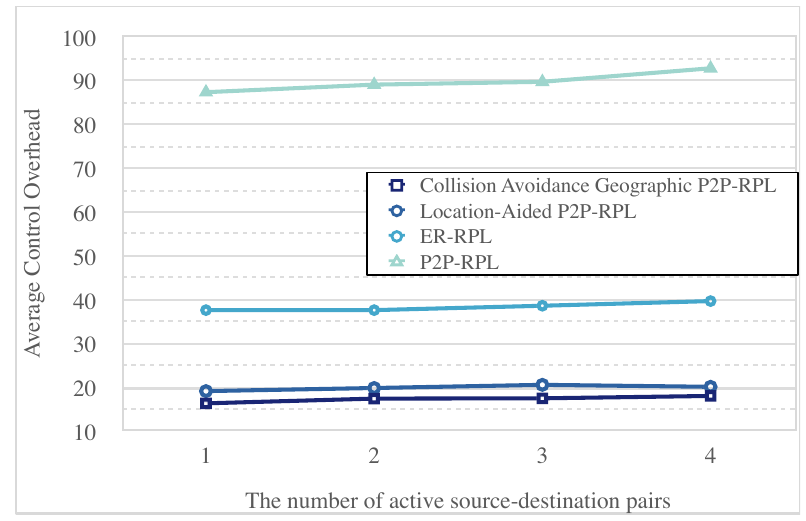
Figure 14. The control packet overhead versus the number of active source-destination